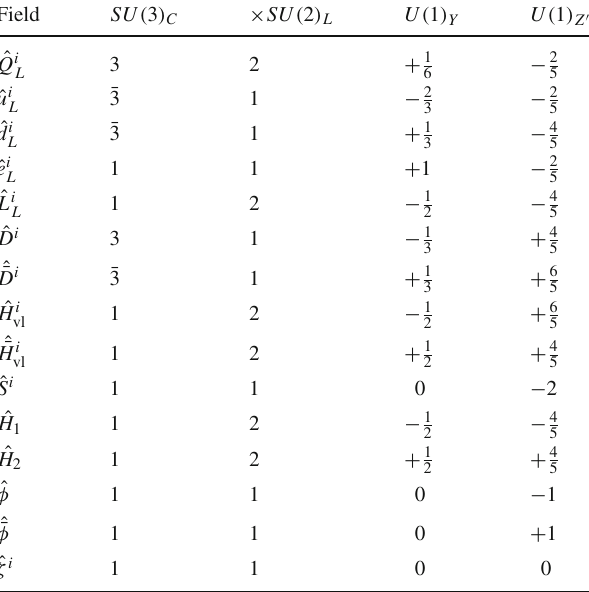
U ( 1 ) Z (cid:2) quantum numbers, with i = 1 , 2 , 3 for the three light gen- erations. The charges are displayed in the normalisation used in free fermionic heterotic-string models Field SU ( 3 )